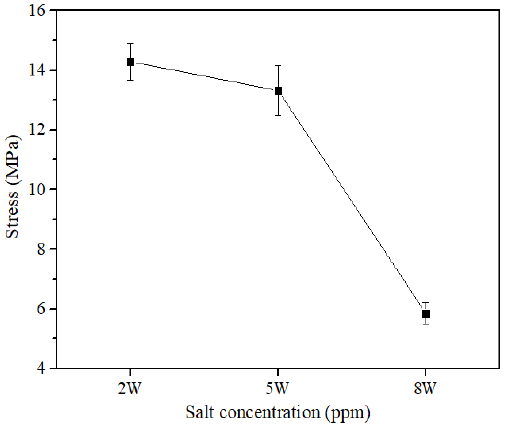
Table 2. Salt tolerance of p–DN hydrogels.